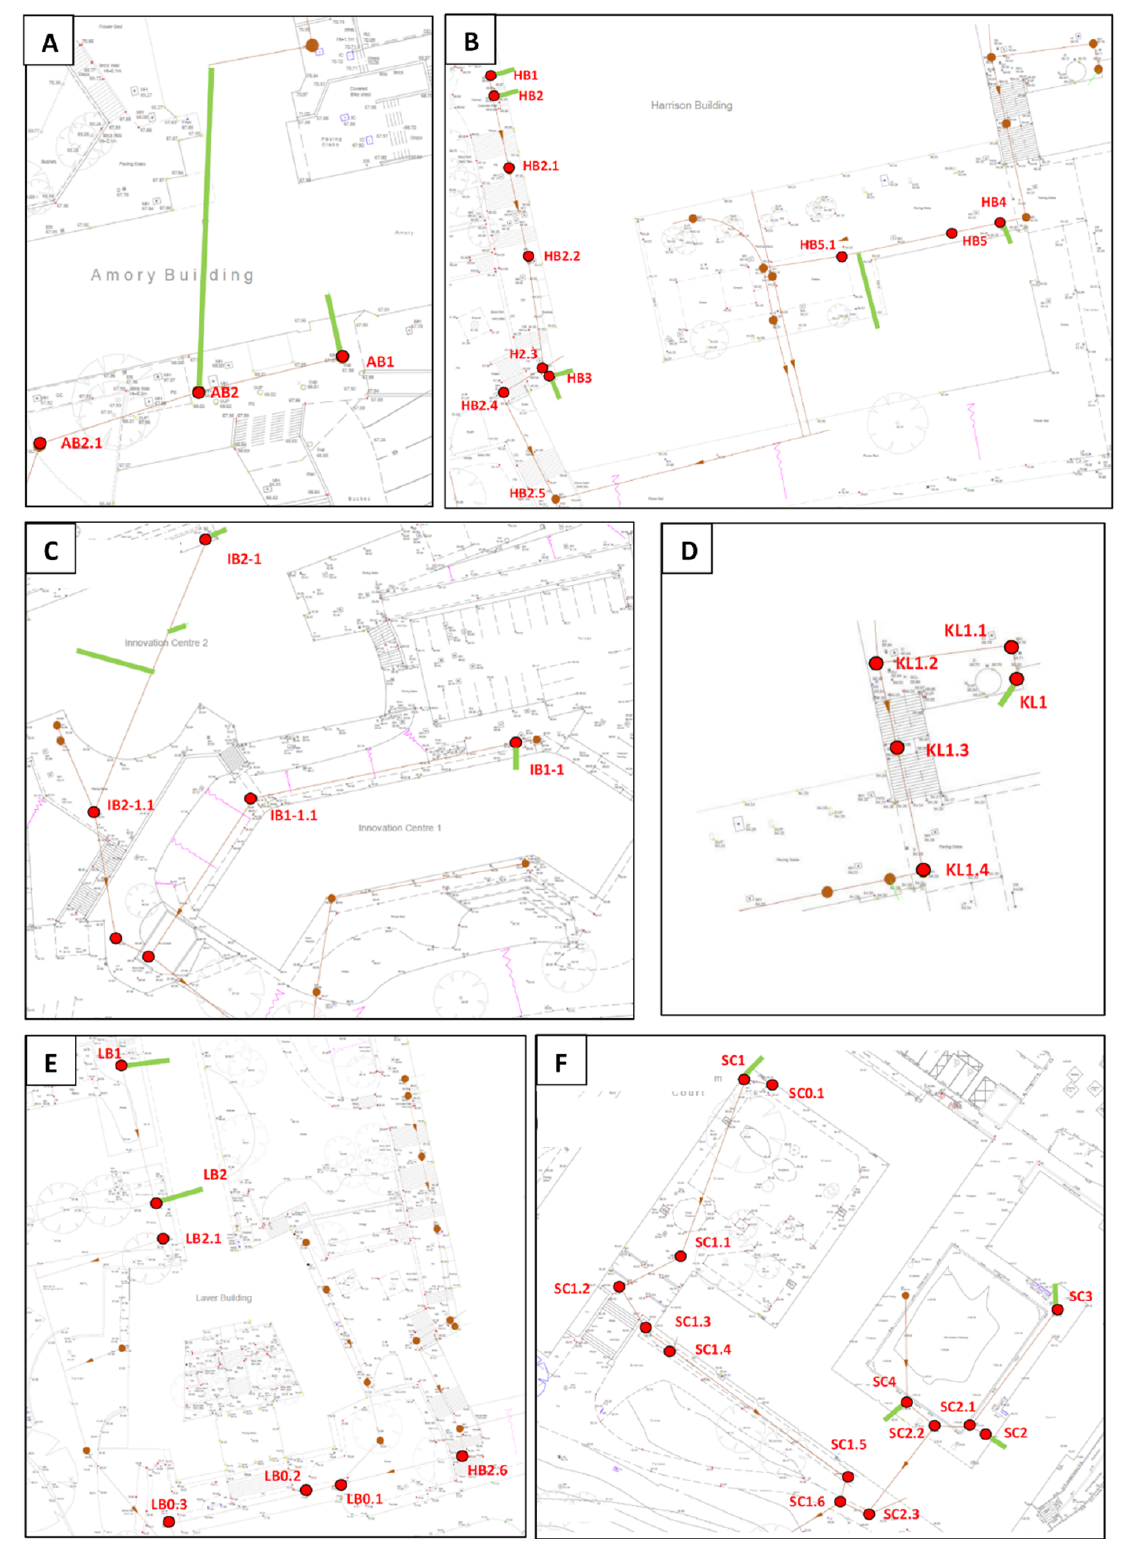
Figure 1. Survey locations for sub sections of the Drainage Survey where: ( A ) Amory Building, ( B ) Harrison Building, ( C ) Innovation 1 and 2, ( D ) Kay Building, ( E ) Laver Building and ( F ) Streatham Court. Red dots indicate manholes surveyed (with associated manhole ID), green lines indicate where a washroom with ULFTs enter a manhole